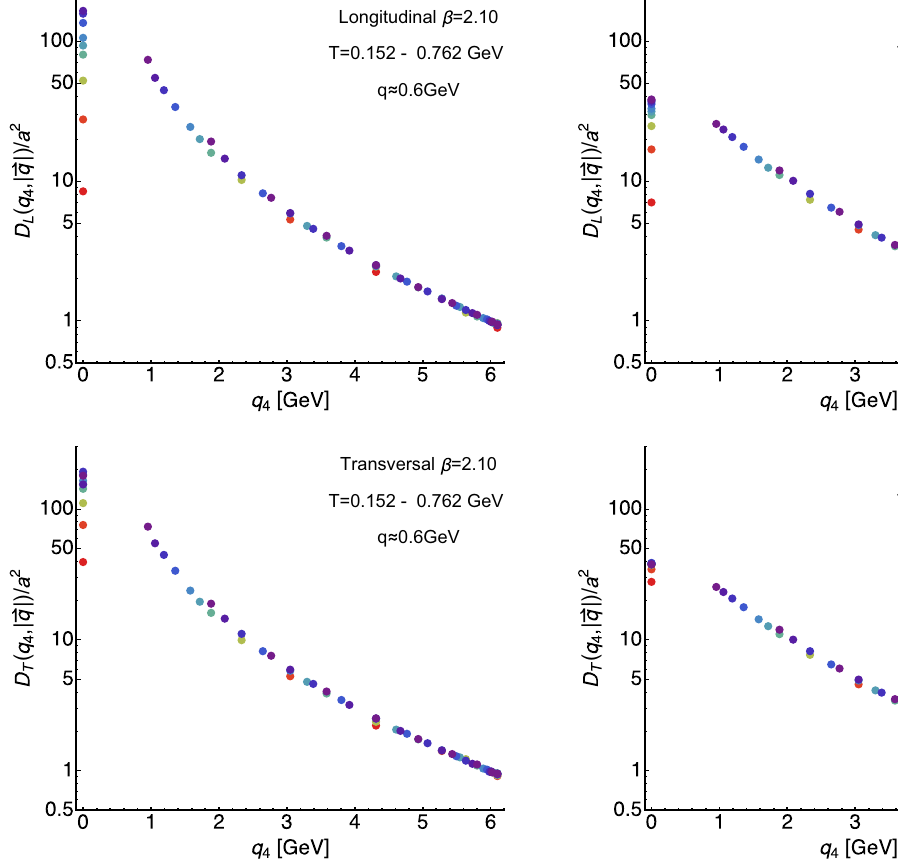
Fig. 5 The longitudinal (top row) and transversal (bottom row) gluon propagators at β = 2 . 10 evaluated along imaginary frequencies for the ten available temperatures among the ensembles of D 370, i.e. T = 152 ... 762 MeV. The left panels contains correlators at | q | ≈ 0 . 6 GeV